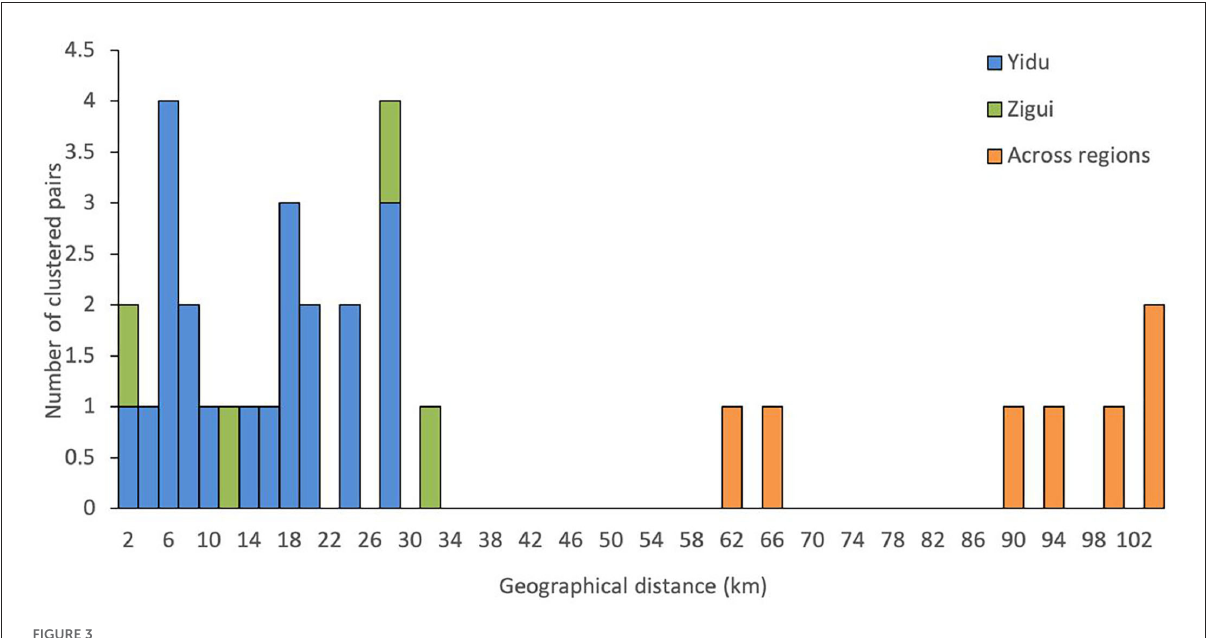
FIGURE3 Spatial and social association of tuberculosis patients with transmission